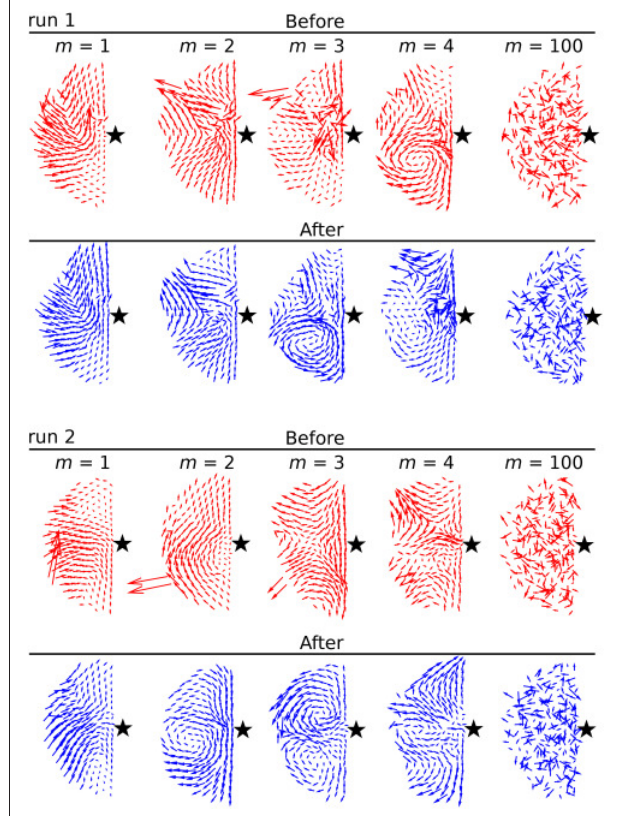
FIGURE 5 | Visualization of five eigenmodes for two independent simulation runs before (red) and after (blue) removing the rattlers with a threshold choice of ξ r 4. Removing rattlers affects the first few eigenmodes by filtering out = large irregularly-oriented vectors, but has little effect at higher m .